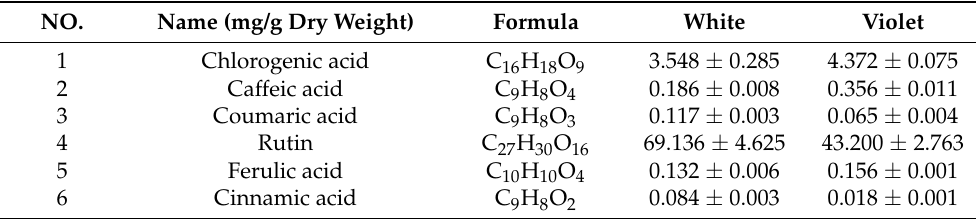
Table 2. Composition and contents of phenolic acids in M. heptapeta (white) and M. denudata var. purpurascens (violet) flower buds. NO. Name (mg/g Dry Weight) Formula